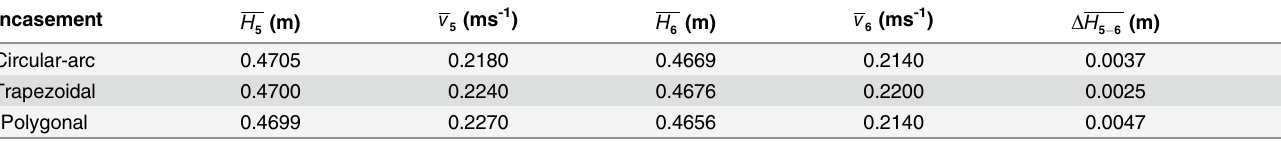
Table 6. Estimated parameters at CS5 to CS6 for a once-in-three-year flood event.